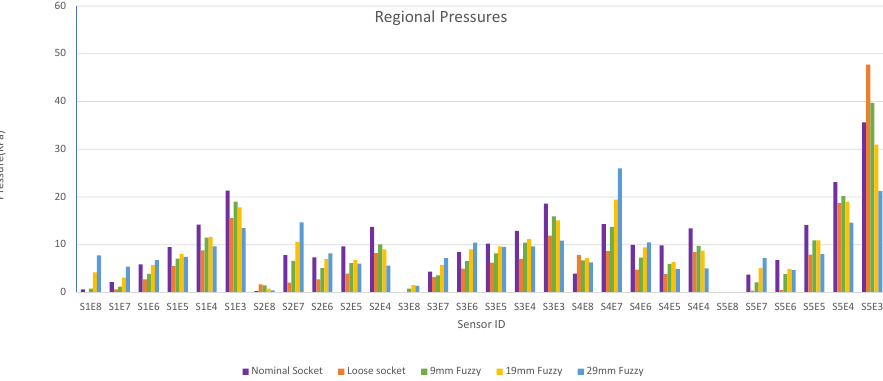
Figure 10. Regional pressure values for nominal, loose and rectified